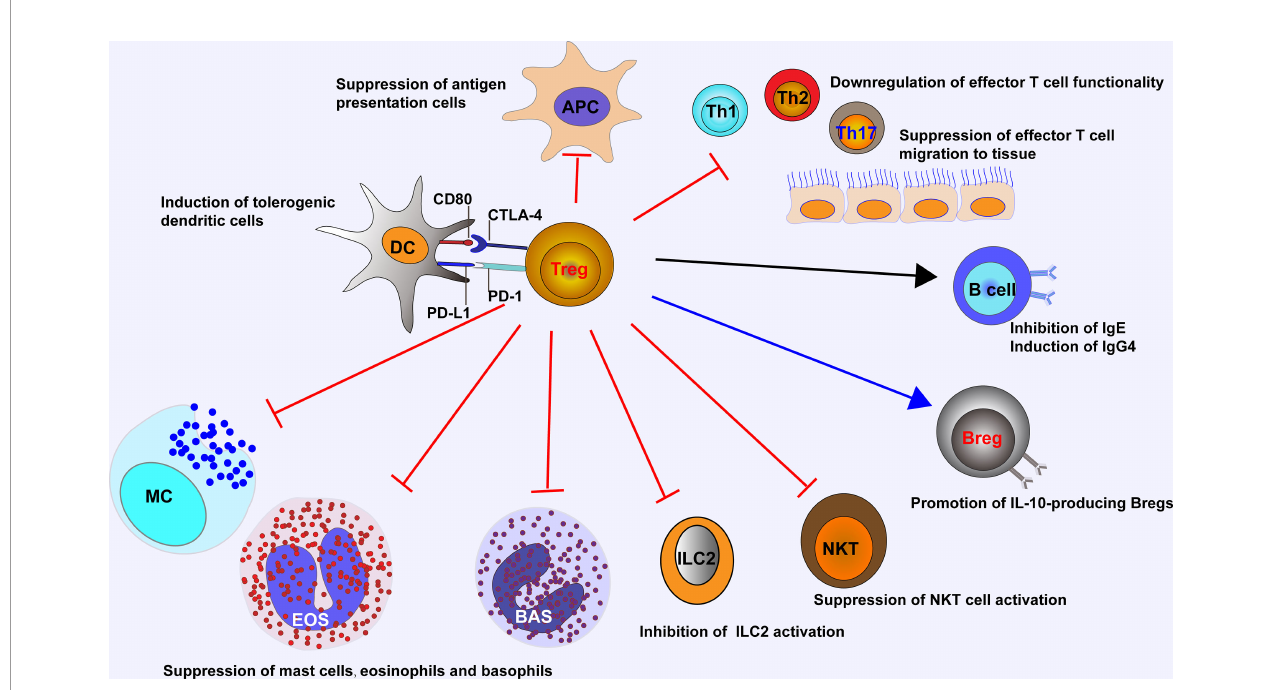
FIGURE 1 | Tregs control ongoing in fl ammation by acting on major cells that drive allergic reaction, including antigen presentation cells, Teffs, NKT cells, ILC2s, eosinophils, basophils, and mast cells. Tregs suppress IgE-producing B cells, while induce IgG4-producing B cells and IL-10-producing Bregs, and promote the generation of tolerogenic dendritic cells. APC, antigen presentation cell; EOS, eosinophil; BAS, basophil; MC, mast